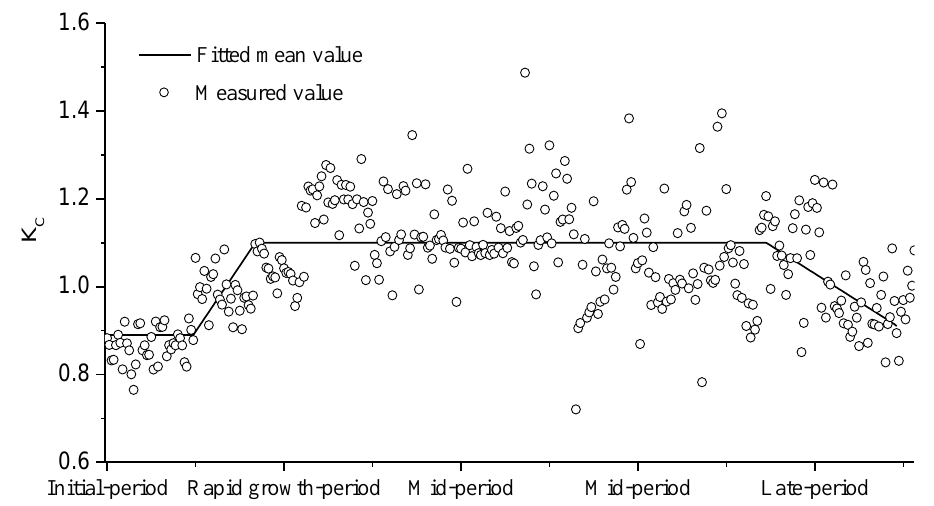
Figure 7. The crop coefficient ( K c ) of rubber plantations. The forecast accuracy of the 7-day horizon forecast values compared with the ET c values of the PM method in 2016 is presented in Table 5. The differences in the forecast values were not significant. In the rainy season, the MAE was 0.57–0.65 mm d − 1 , RMSE was 0.73–0.83 mm d − 1 , the R ranged from 0.70–0.65. While in the dry season, these values